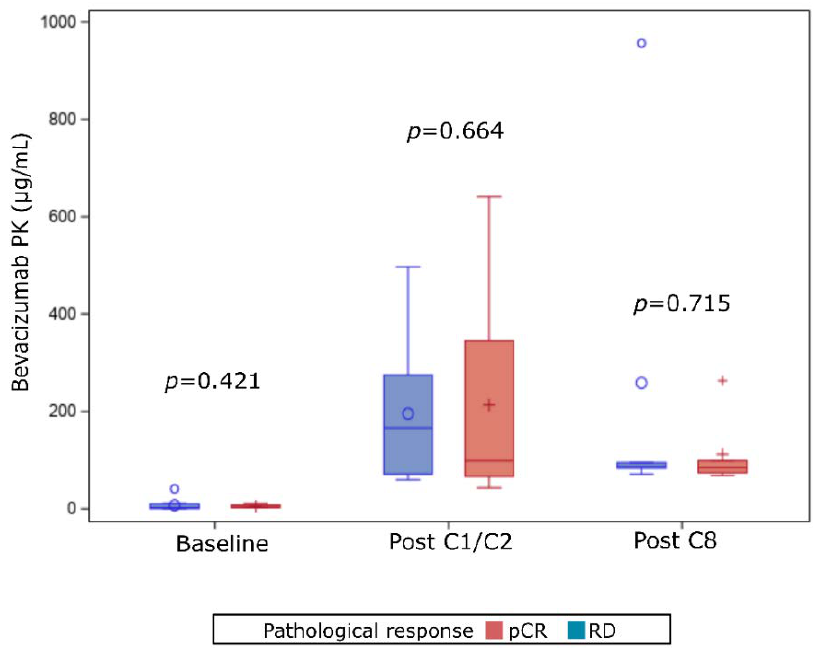
Figure 4. Bevacizumab PK values according to pathological response for patients enrolled in the experimental arm. pCR: pathological complete response; RD: residual